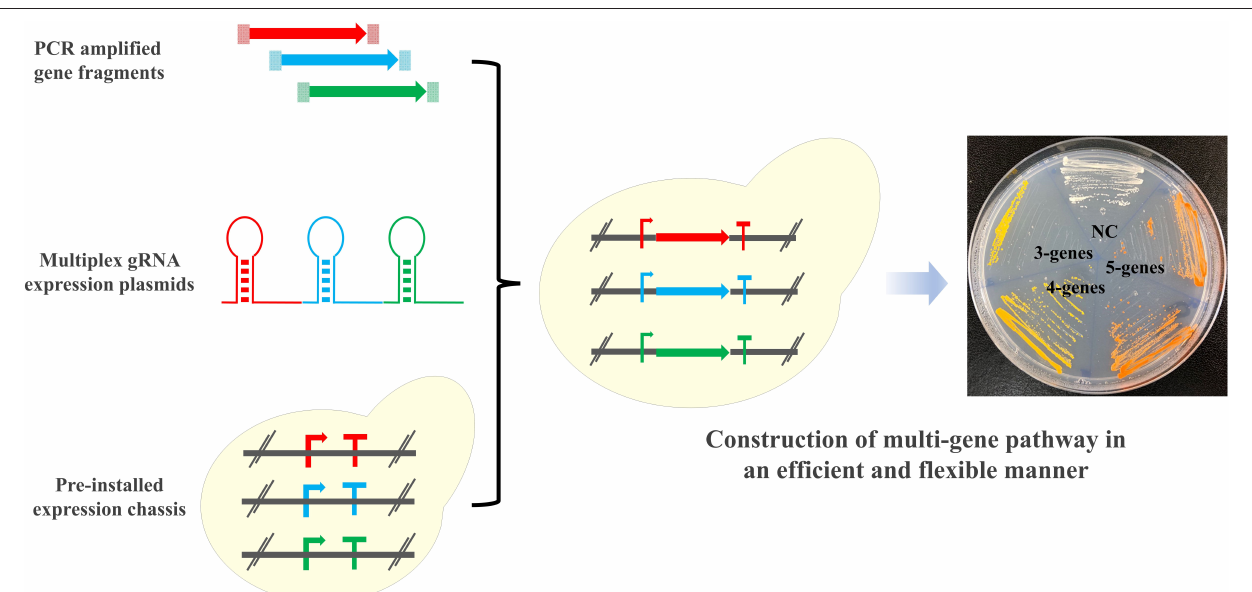
genes involved in β -carotene biosynthesis (84% integration efficiency with 500 bp homology arms) (Ronda et al.,